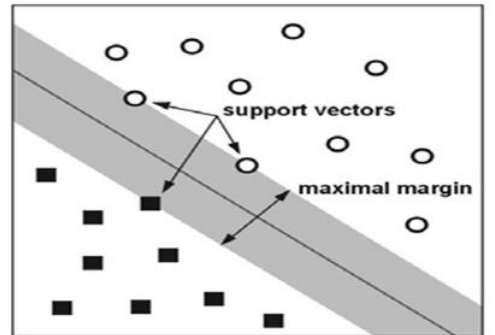
Figure 5. Concept of optimal surface based on maximize the